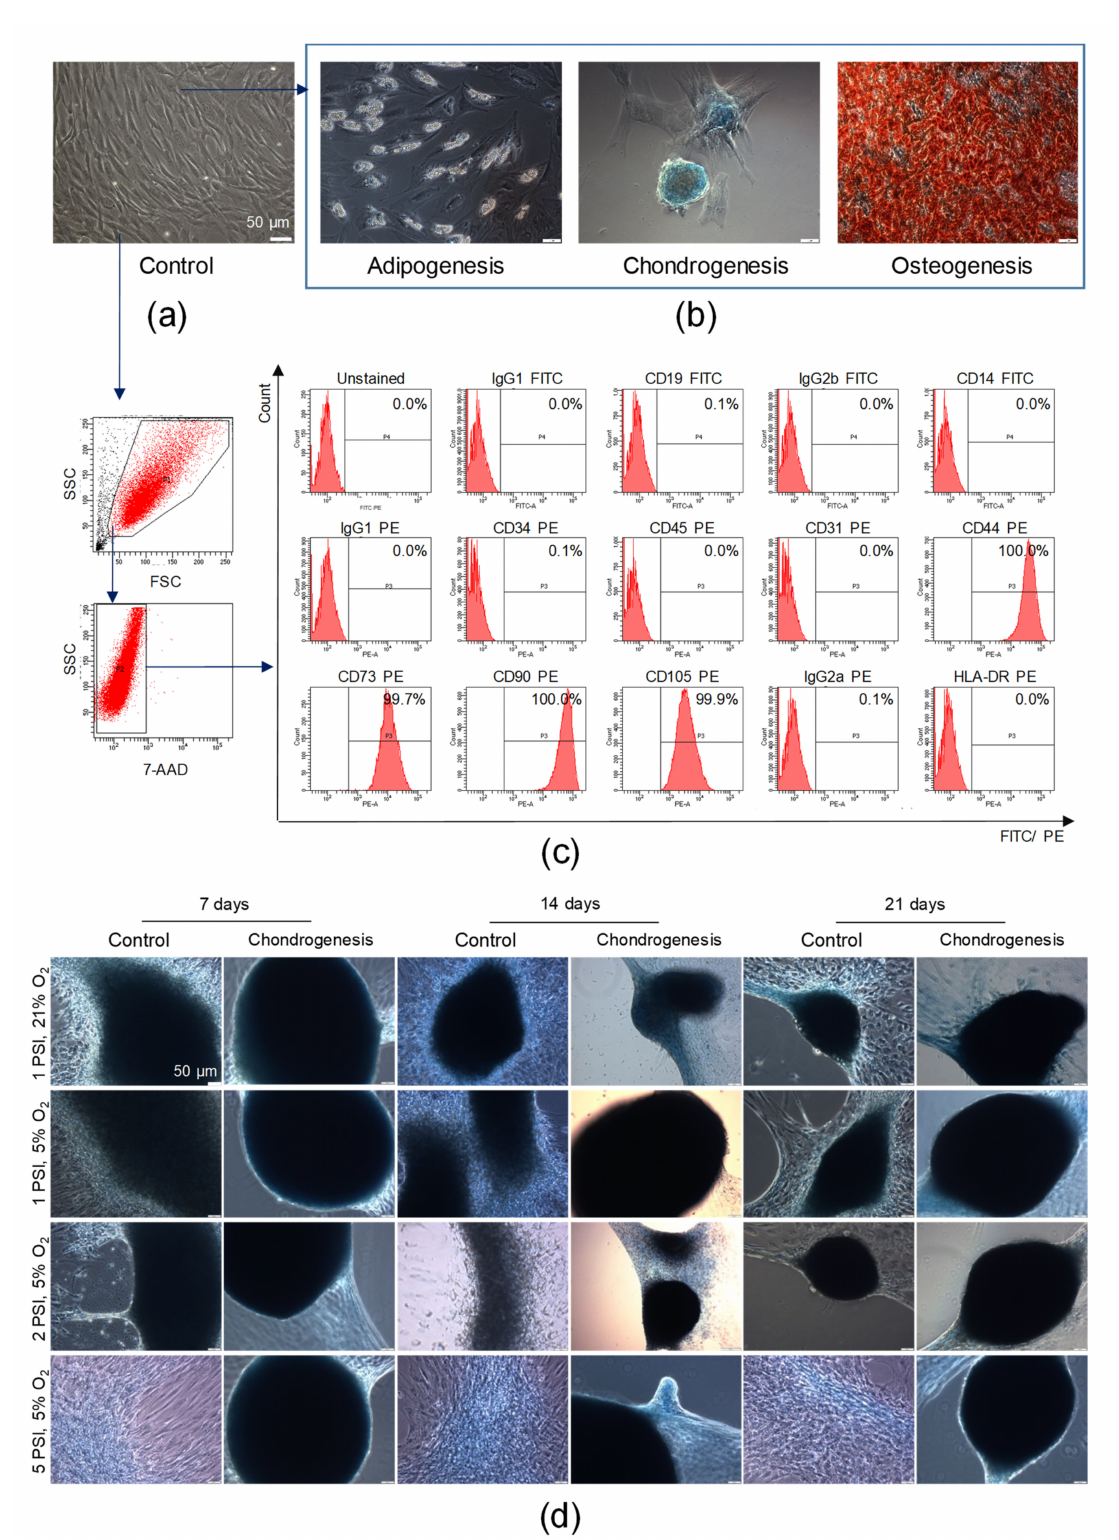
Figure 4. Characterization of AT-MSCs according to the criteria defining multipotent MSCs proposed by the International Society for Cellular Therapy and their chondrogenic potential. ( a ) Representative images of the morphology of